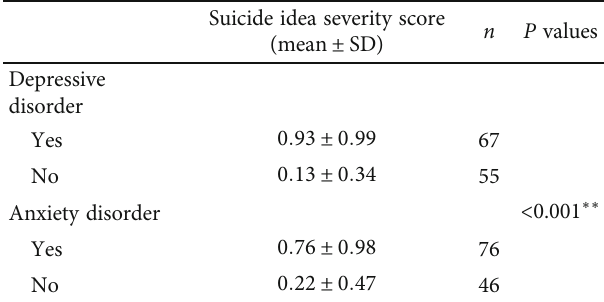
Table 2: Suicide severity analyses in di ff erent categorical